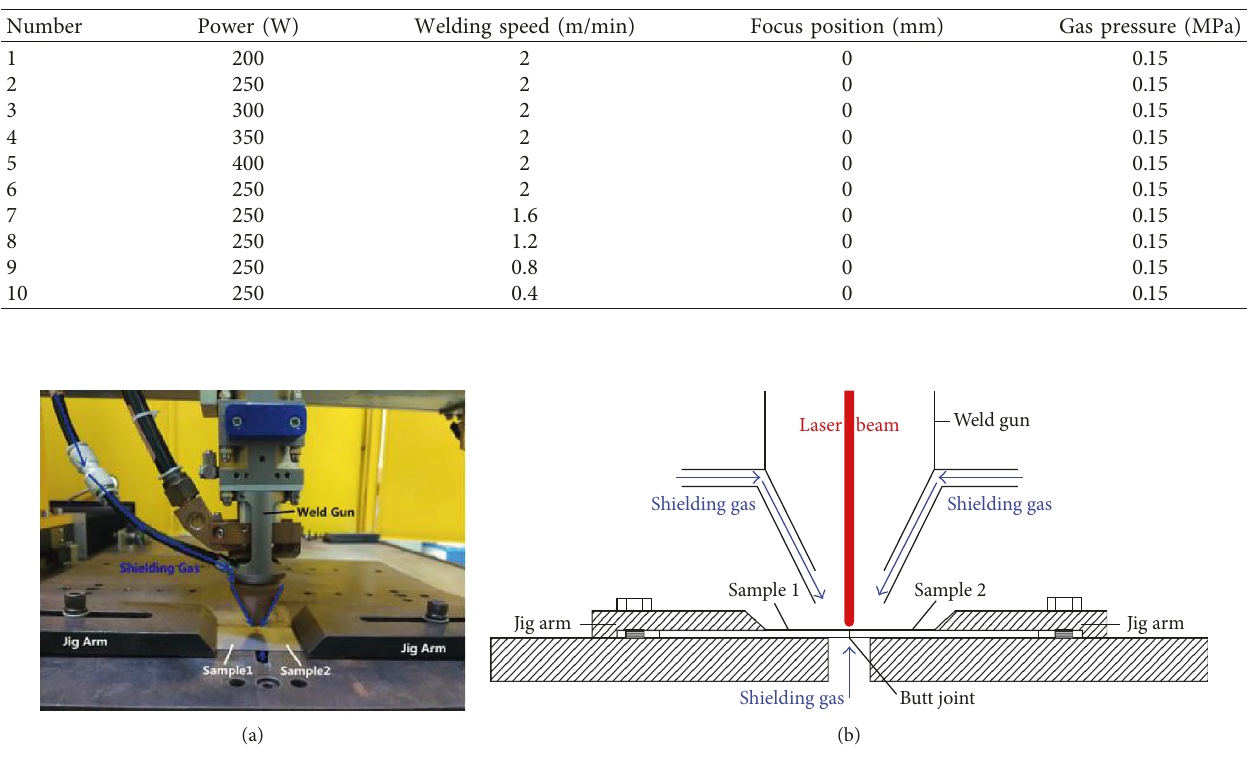
Table 2: Process parameters of laser welding in different